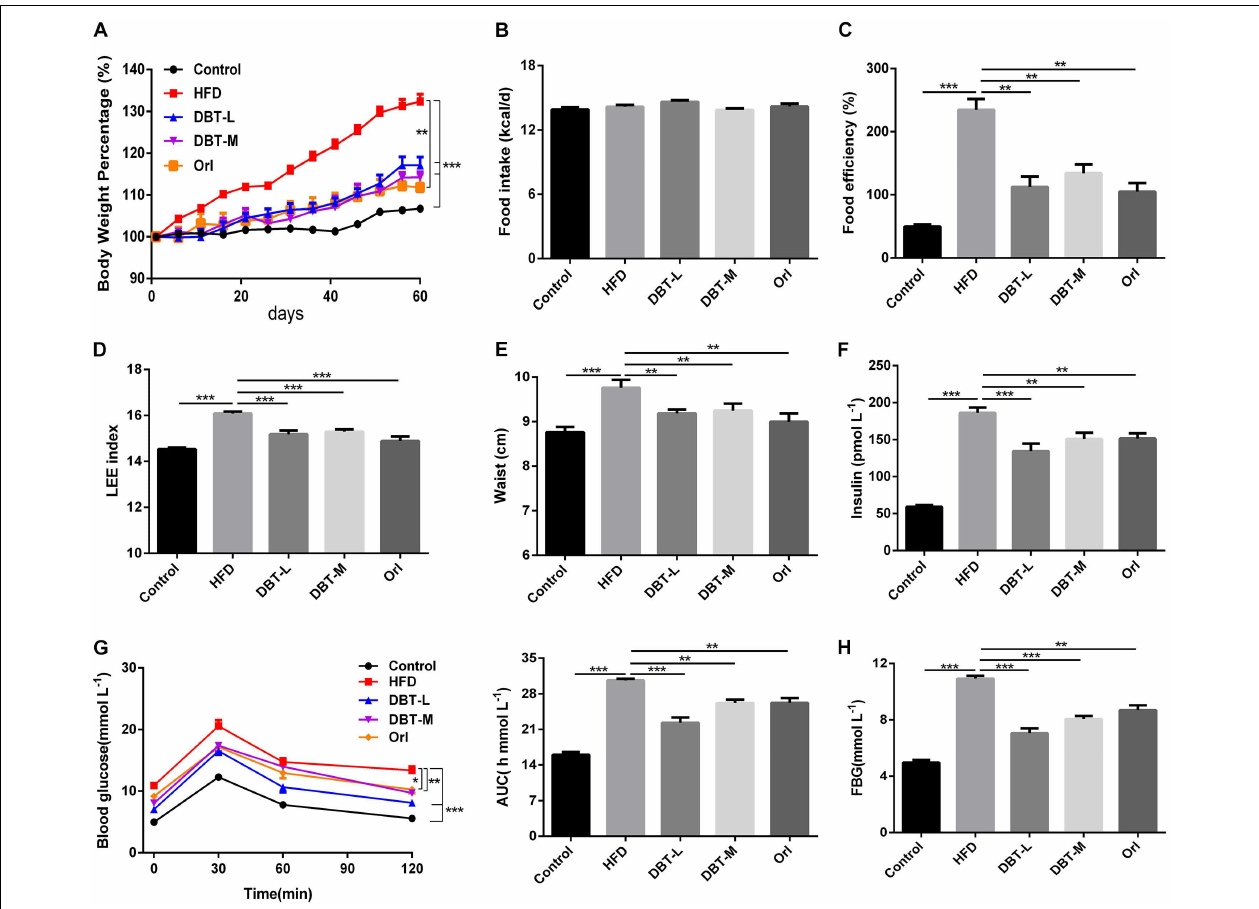
FIGURE 1 | DBT prevents obesity and improves glucose metabolism. (A) Body weight percentage of high-fat diet-induced obese mice; (B) Food intake of mice per day; (C) Food efficiency of mice; (D) LEE index; (E) Waist circumstance; (F) fasting insulin levels; (G) Oral glucose tolerance test and the average area under the curve of oral glucose tolerance test; (H) Fasting blood glucose levels. Results are presented as mean ± SEM ( n = 7). ∗ p < 0.05, ∗∗ p < 0.01, ∗∗∗ p < 0.001 compare with HFD